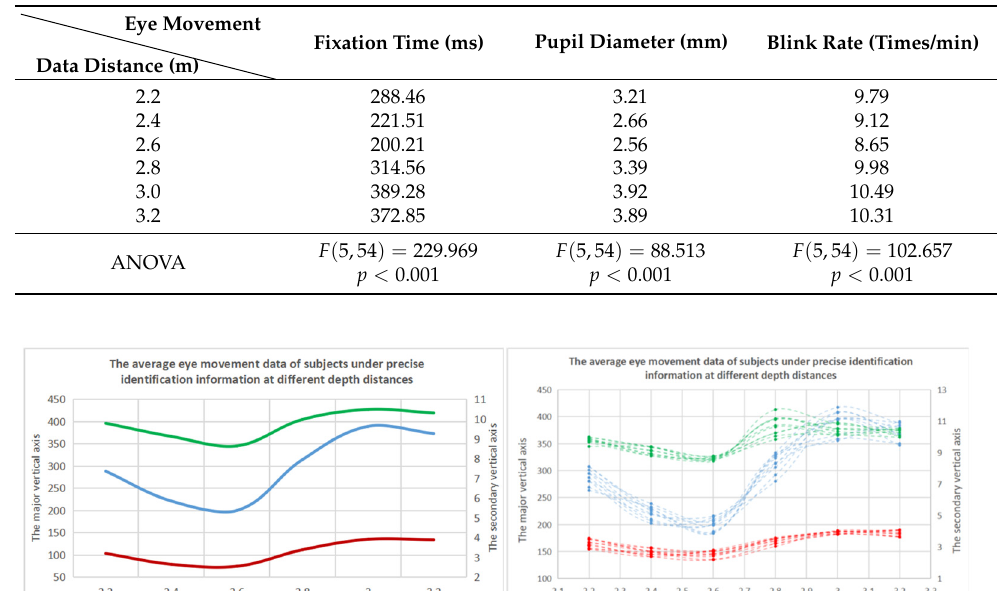
Table 7. Average eye movement data after the depth and distance range of the accurate identification information is divided.